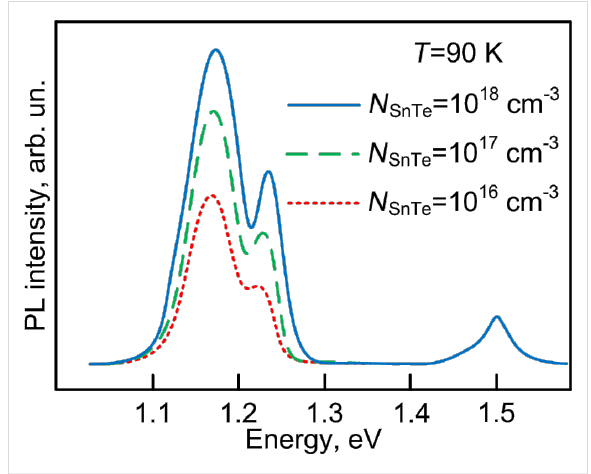
Figure 8: Photoluminescence spectra of the grown InAs/GaAs struc- tures with different levels of doping of the GaAs barrier layer.